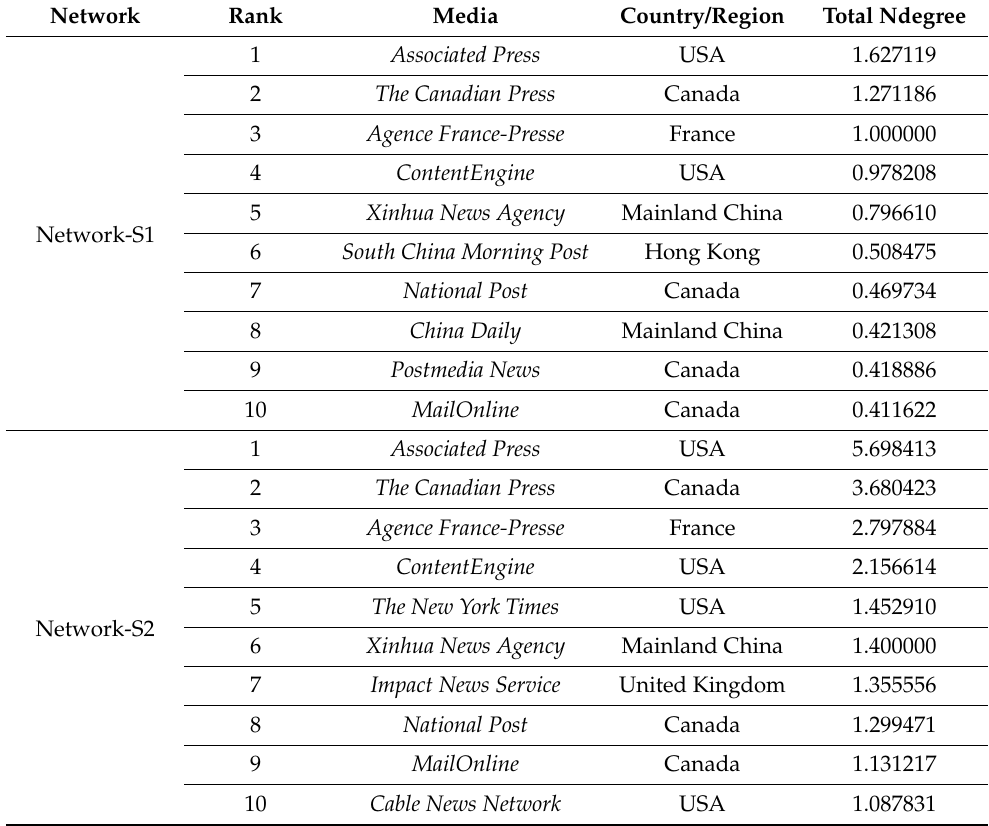
Table 3. Top 10 Media Outlets in Terms of the Level of